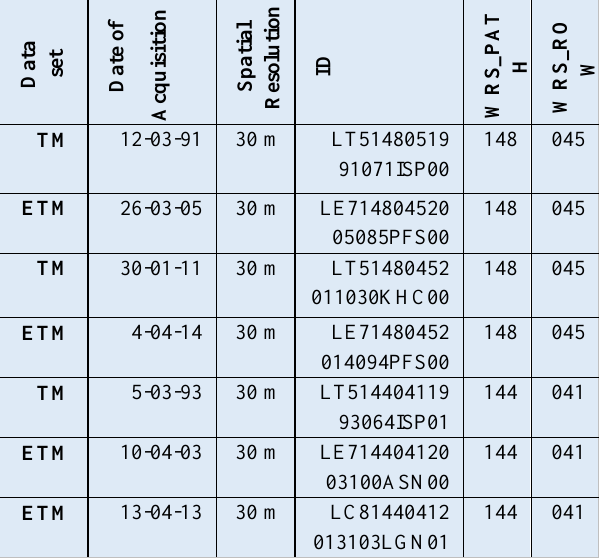
Table 3: Satellite